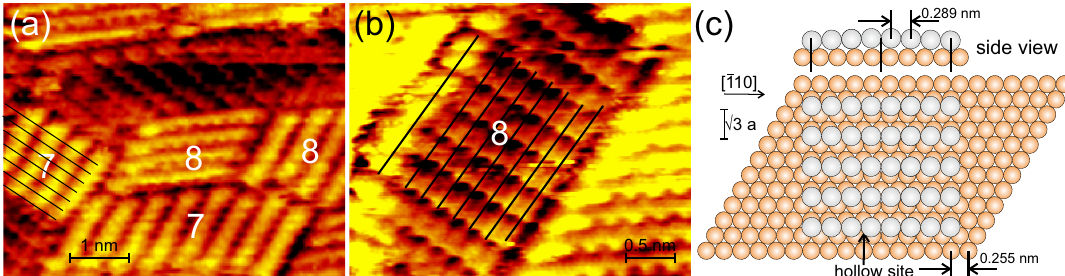
Figure 4. Atomic resolution of rods; number gives length N in atoms: ( a , b ) STM images; solid lines mark rows of atoms; deposition rates: 0.65 ML/min; tunneling parameters: ( a ) 1.06 nA, 221 mV; ( b ) 1.07 nA, 186 mV; ( c ) Model: orange balls — Cu atoms, grey balls — silver